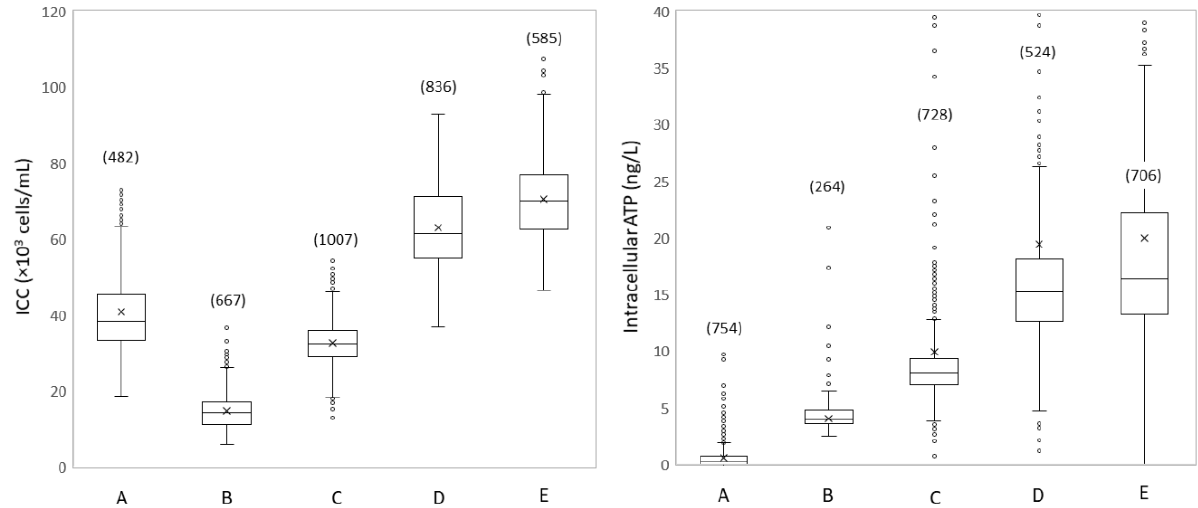
Figure 3. Range of FCM intact cell concentrations ( left ; ICC) and intracellular ATP concentrations ( right ) at the treatment effluent (A) and four locations over water transport (B–D) and distribution (E) trajectory. Box plots show the first, second (median), and third quartiles, whiskers show the data range, circles show outlier values, and a cross (x) indicates the mean value. The number of measurements are shown between brackets. For ATP data, outliers for locations C (9 outliers), D (18 outliers), and E (26 outliers) up to 700 ng/L are out of scale.